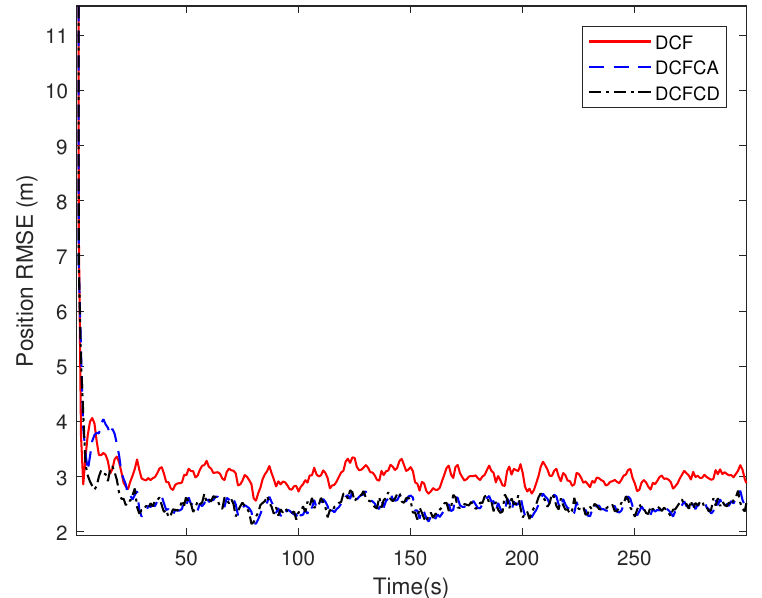
Figure 14. The position RMSE for different methods over time with 100 sensor